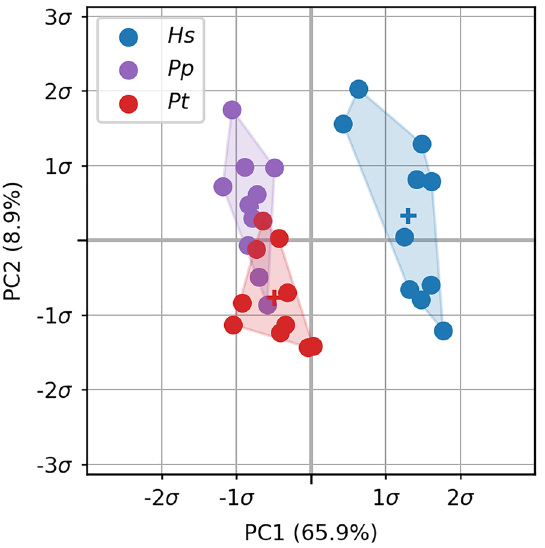
Figure 6. PCA plot of the first metacarpals. The plot shows the first two components in the principal component space for rBVTV. Hs Homo sapiens , Pp Pan paniscus , Pt Pan troglodytes .